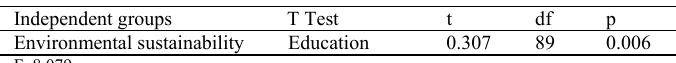
Table 7: T-test results of environmental sustainability